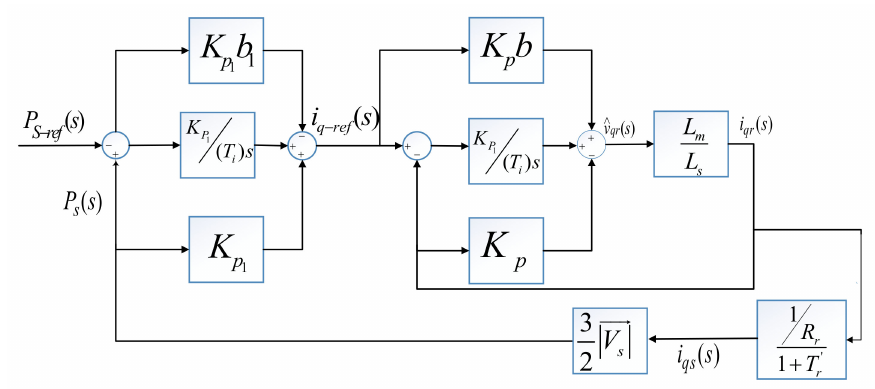
Figure 6. Control loop related to stator active power.